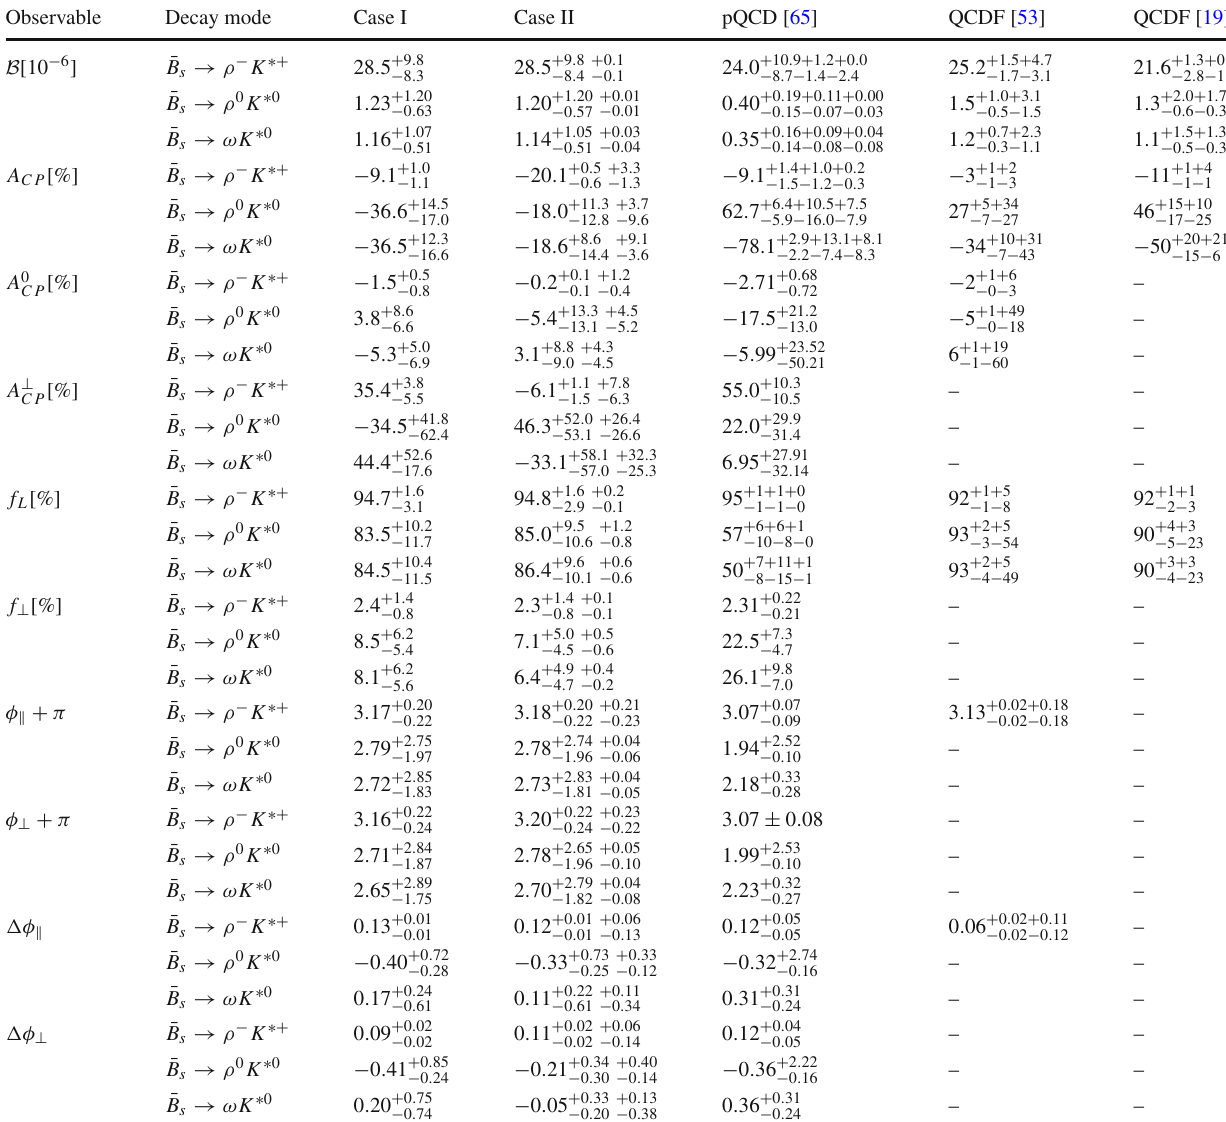
Table 4 Theoretical results for the b → d induced ¯ B s → ρ − K ∗+ , ρ 0 K ∗ 0 and ω K ∗ 0 decays